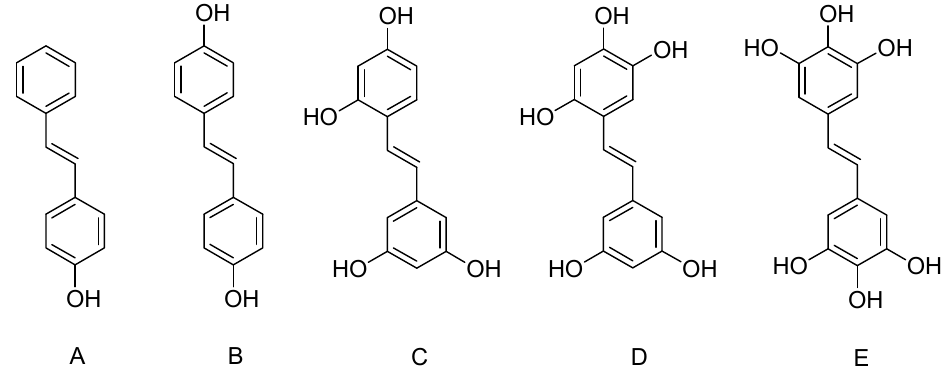
Figure 3. Chemical structure of selected hydroxylated resveratrol derivatives. ( A ) Hydroxystilbene; ( B ) dihydroxystilbene; ( C ) Tetrahydroxystilbene; ( D ) Pentahydroxystilbene; ( E ) Hexahydroxystilbene.